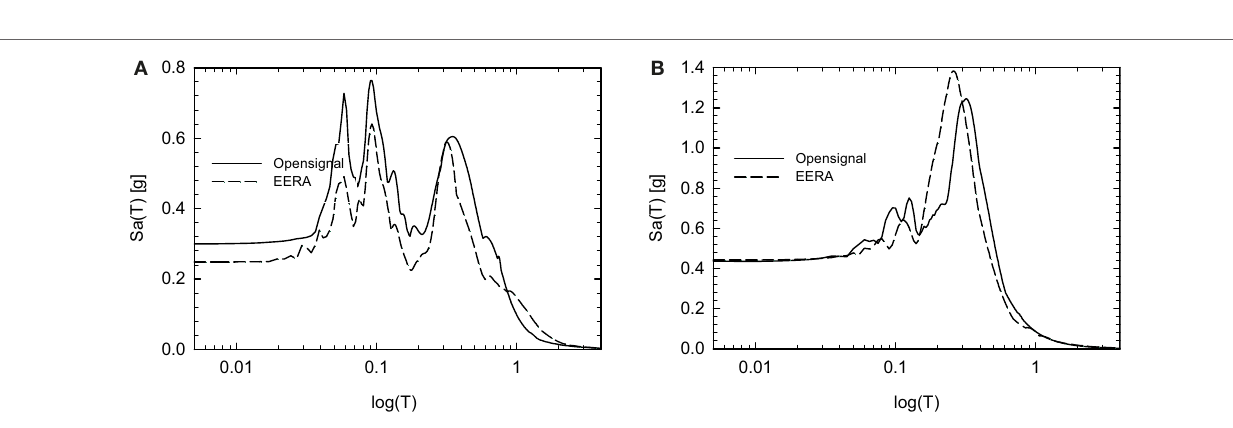
FigUre 14 | Val nerina earthquake (a) and Friuli earthquake (B) comparisons between eera and OPensignal results .